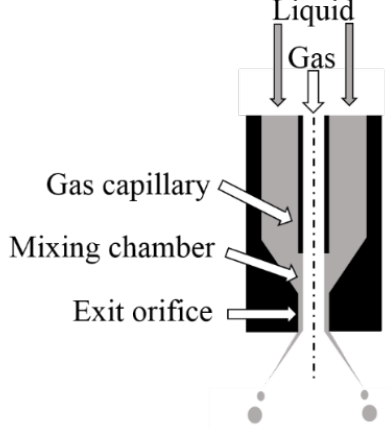
Figure 1. Scheme of the Air-Core-Liquid-Ring (ACLR) atomizer. (d capillary = 1.5 mm; d exit orifice = 1.5 mm; l exit orifice = 1.5 mm; l mixing chamber = 2.4 mm).